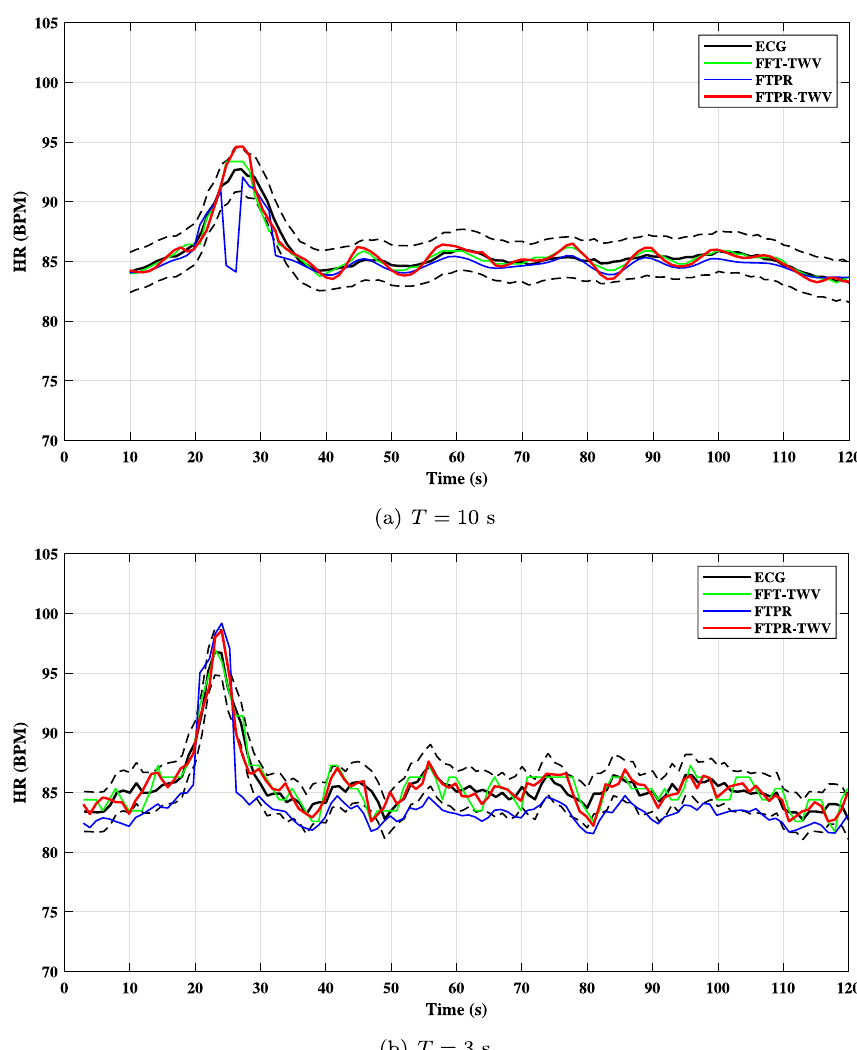
Fig. 9 An example showing the comparison of HR estimated of different algorithms from dataset